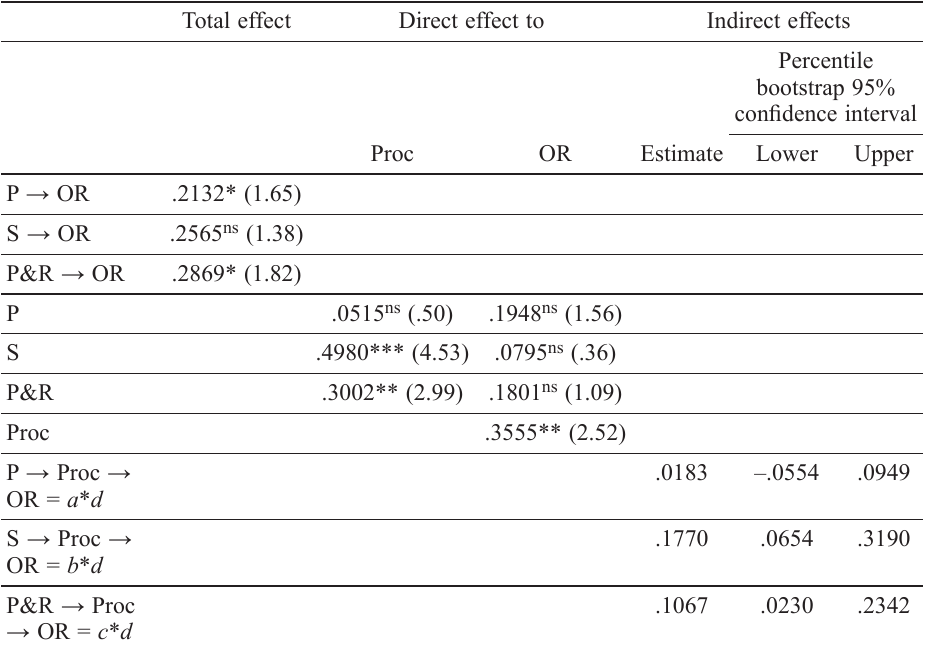
Table 6. Summary of mediating effect